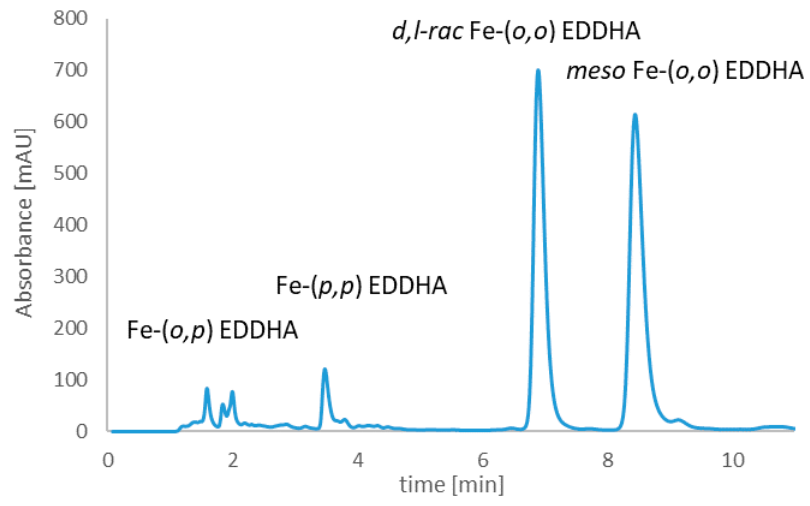
Figure 4. Iron(III) ethylenediamine- N,N ′ -bis(hydroxyphenylacetic) acid chelate chromatogram, which was used to study the changes in the content of chelate and iron(III) ions over time.